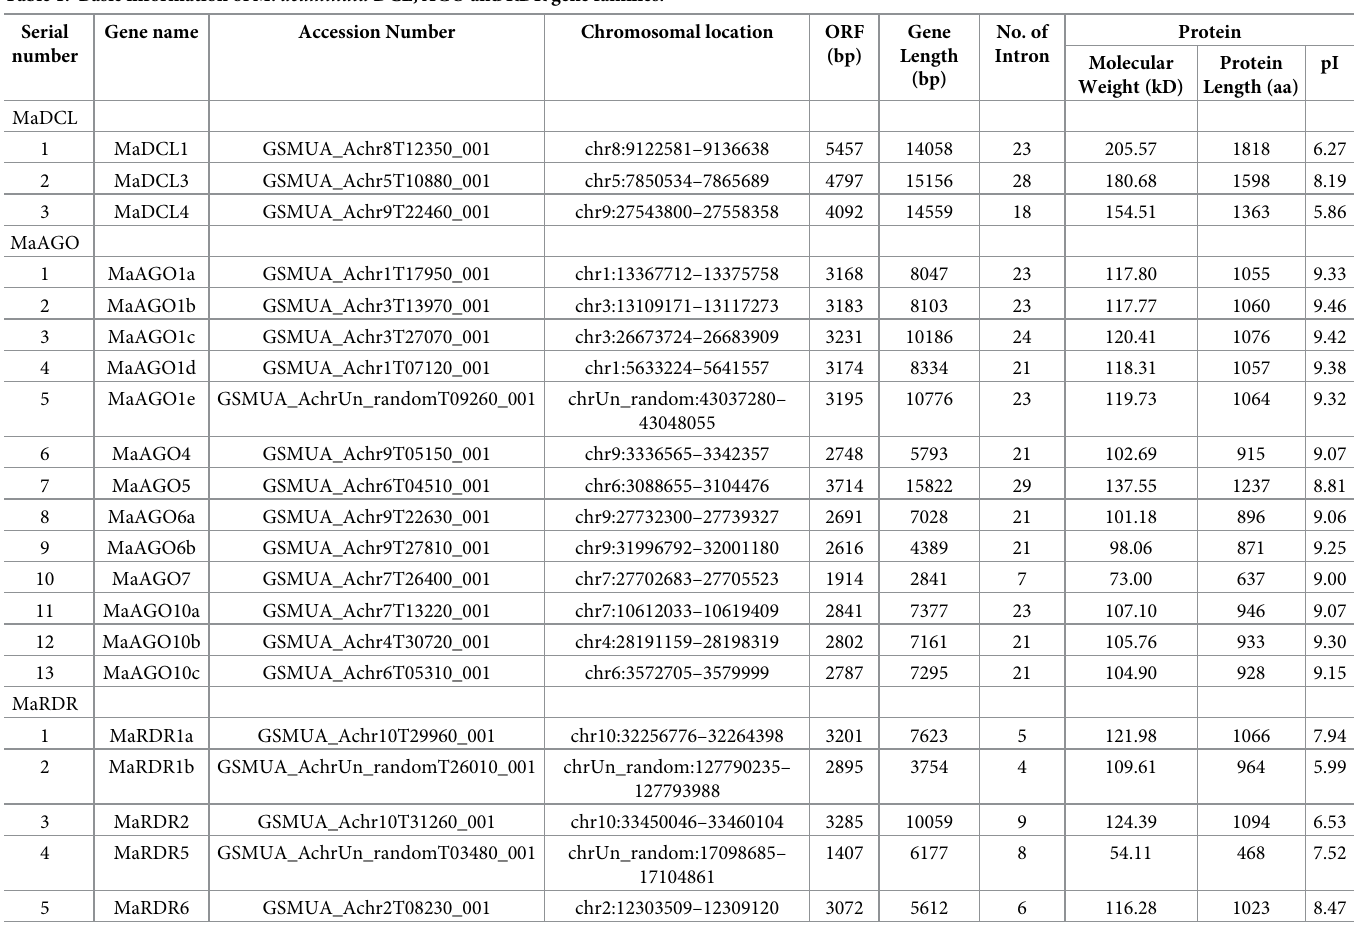
Table 1. Basic information of M . acuminata DCL, AGO and RDR gene